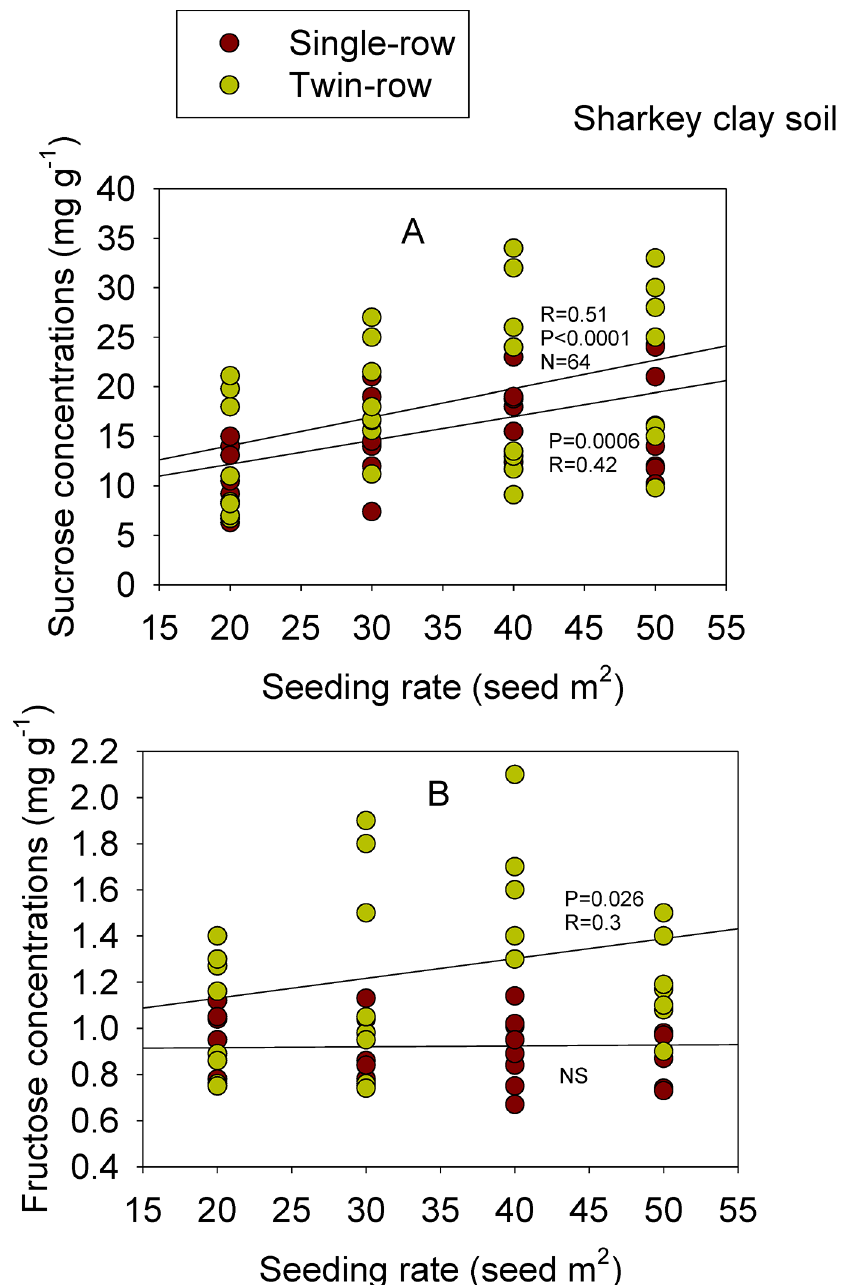
Fig 1. Correlation between seeding rate (SR) and soybean seed sucrose (A) and fructose (B) on single- and twin-rows in Sharkey clay soil across cultivars and